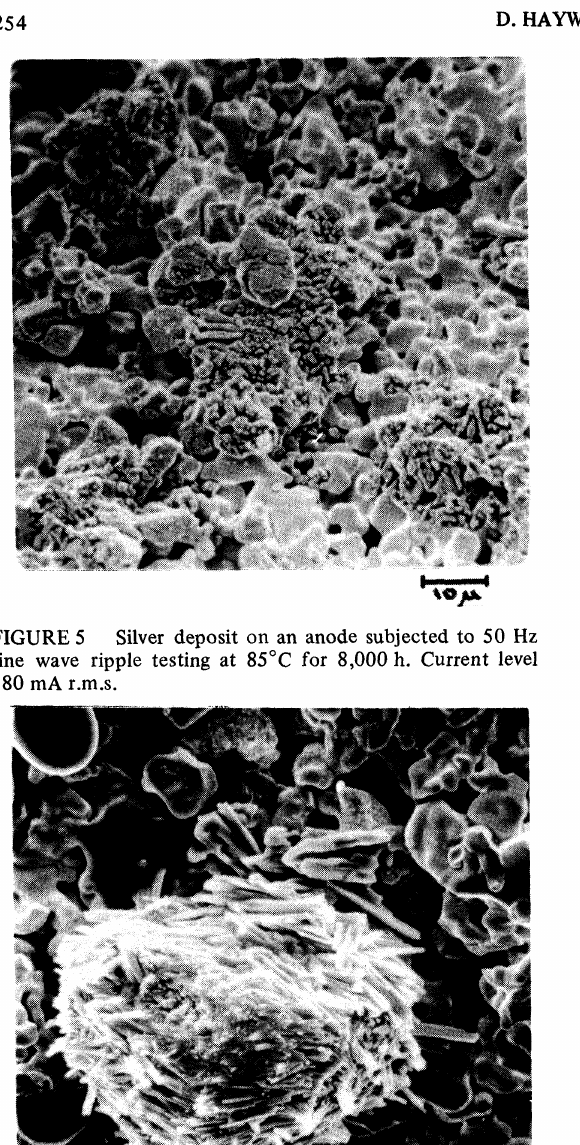
Silver deposit on an anode subjected to 20 kHz sine wave ripple testing at 85C for 8,000 h. Current level 180 mA r.m.s.